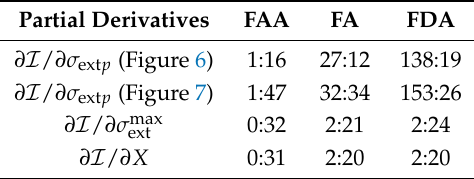
Table 5. CPU time in min:sec for the test problems considered in this study and corresponding to the linearized forward-adjoint approach (FAA), the linearized forward approach (FA), and the finite-difference approach (FDA). The detector zenith angle is θ 0 m = 45 ◦ and the solar azimuthal angle is ϕ 0 = 0 ◦